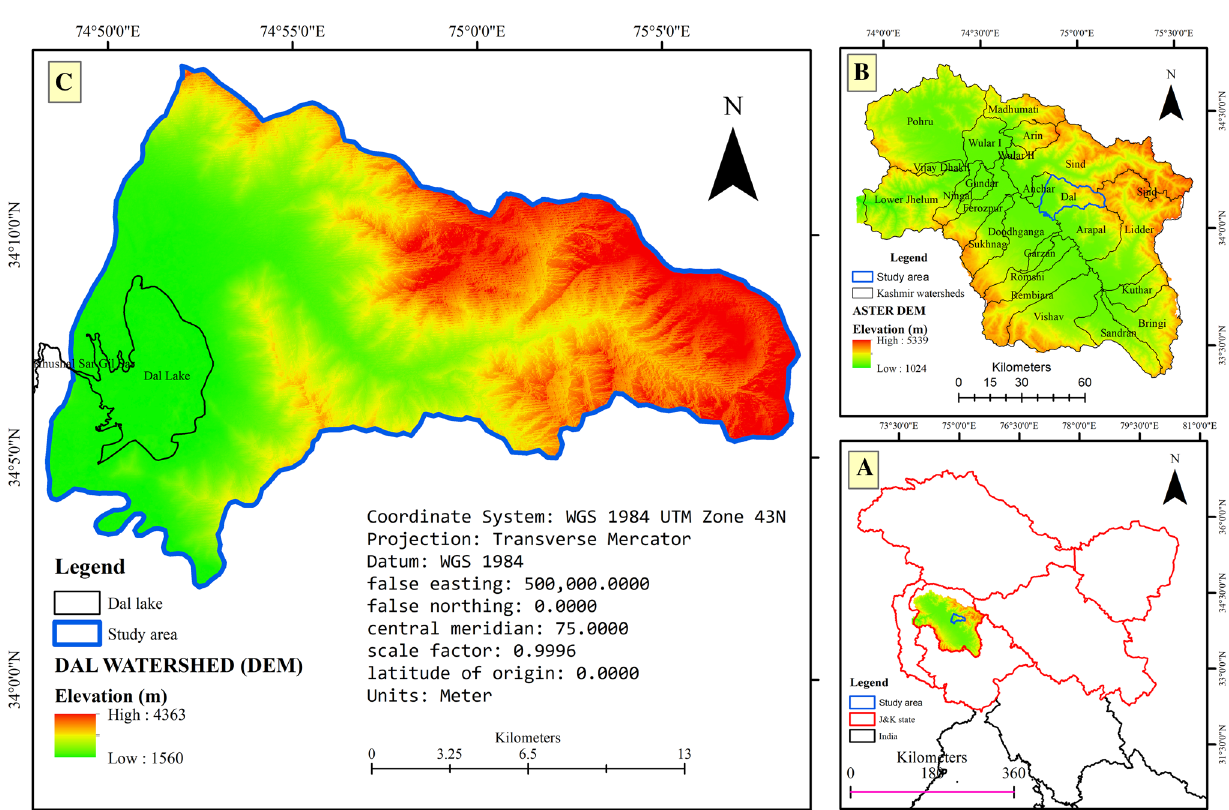
Fig. 1 Location of the study area with respect to India and the UT of